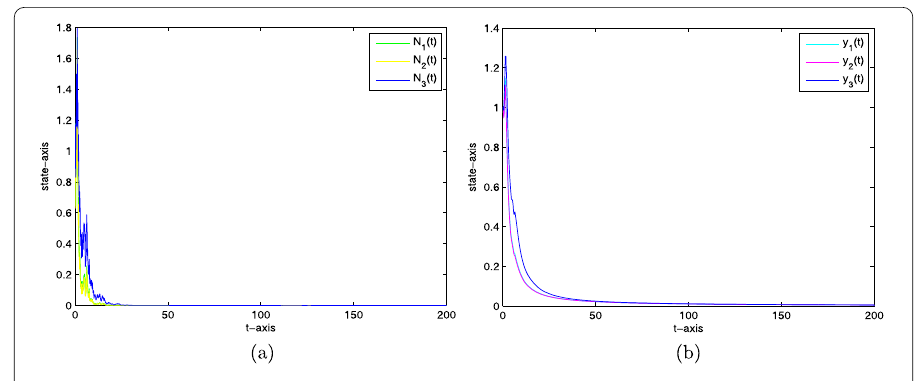
Figure 1 Extinction of all species of system (1.2) with ξ 1 = 0.8, ξ 2 = 0.8, ξ 3 = 0.5292. ( a ) Extinction of N 1 , N 2 , N